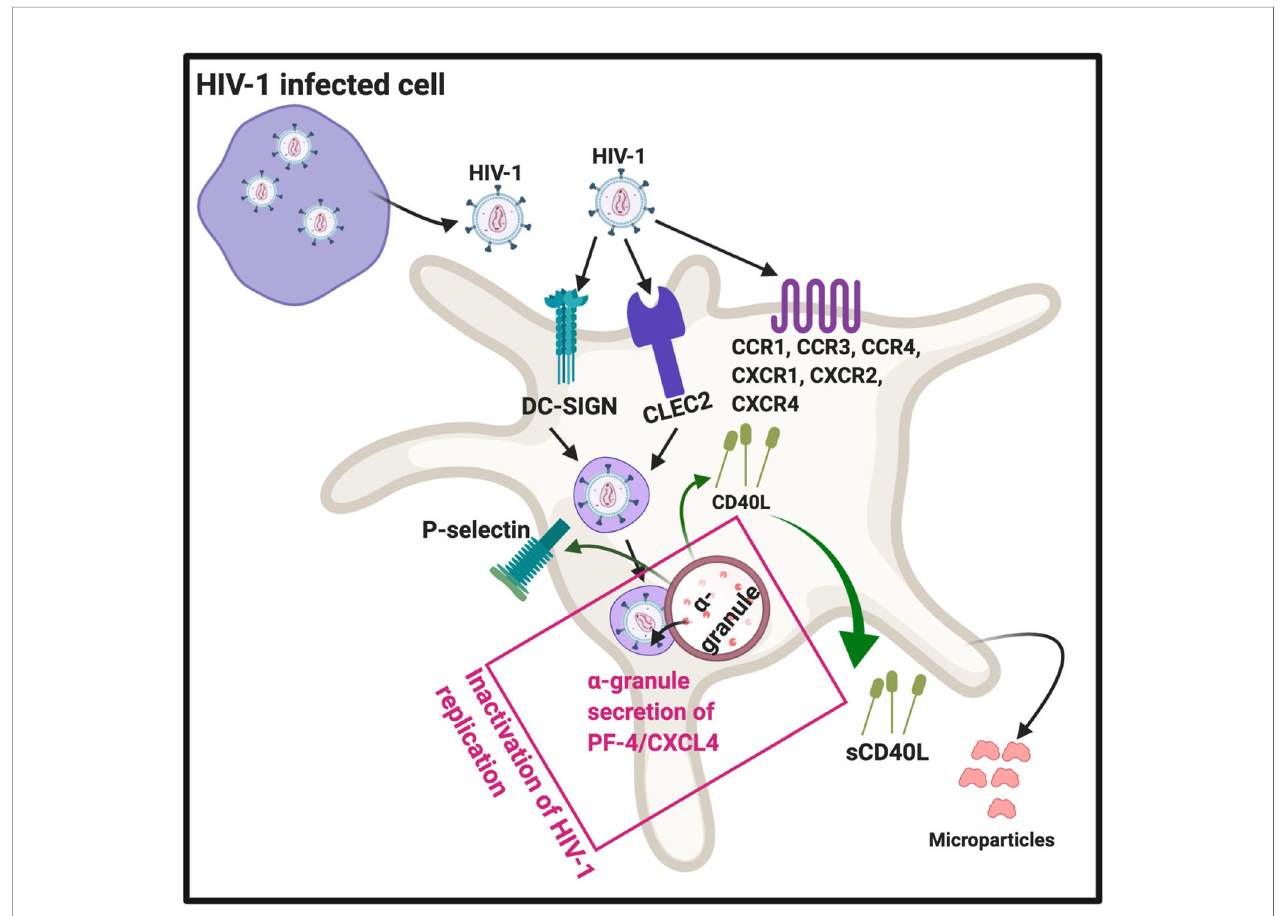
FIGURE 3 | HIV-1 interact with platelets, resulting in (hyper)activation and microparticle formation. Platelet receptors that are known to bind viruses (16): C-C chemokine receptor type 1, 2 and 4 (CXCR1, CXCR2, CXCR4), as well as C-C chemokine receptor type 1, 3 and 4 (CCR1, CCR3 and CCR4). Diagram created with BioRender